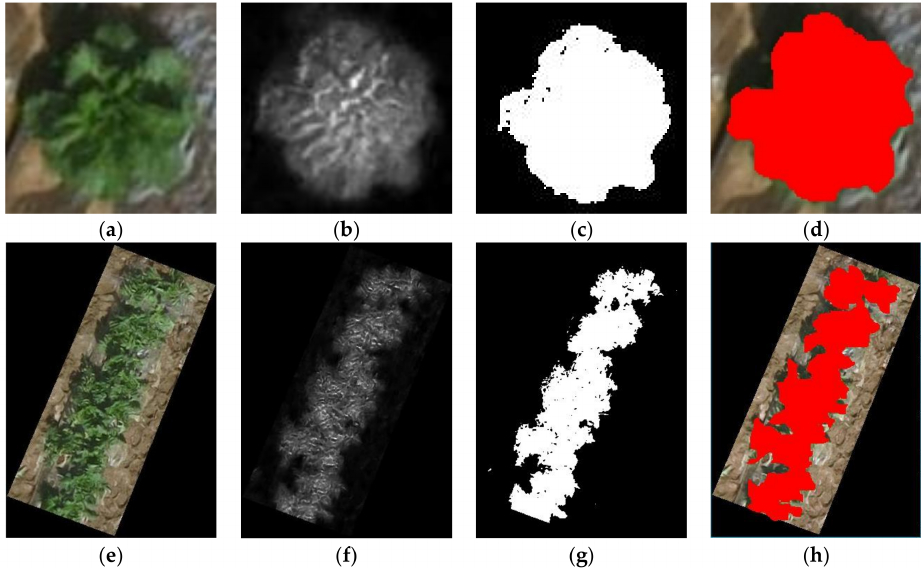
Figure 8. Crop Segmentation Steps: Original red, green and blue (RGB) images of ( a ) Chinese cabbage and ( e ) white radish; Excess green (ExG)-converted images of ( b ) Chinese cabbage and ( f ) white radish; Segmented binary images obtained using the Otsu threshold based on ExG of ( c ) Chinese cabbage and ( g ) white radish; Manually segmented images of ( d ) Chinese cabbage and ( h ) white